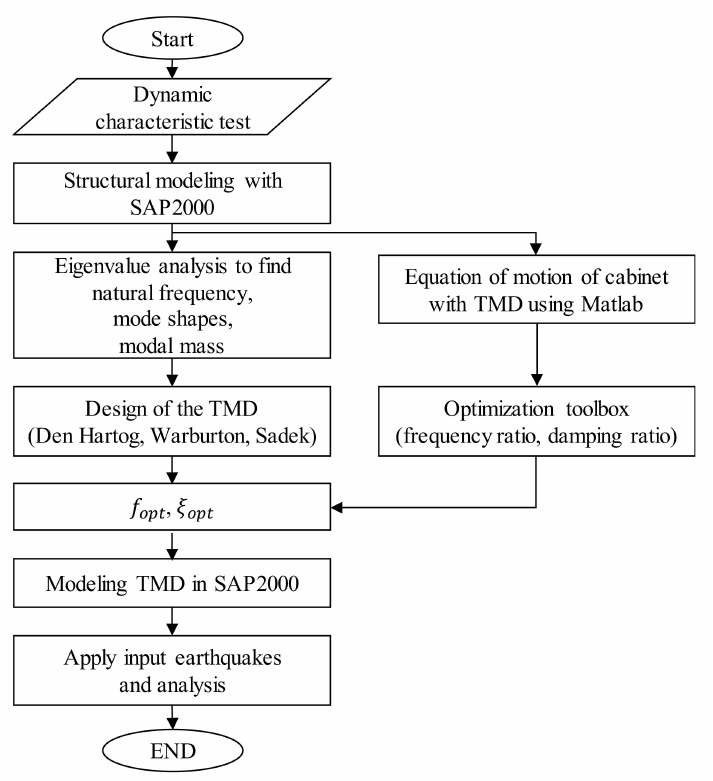
Figure 1. Tuned mass damper (TMD) design and analysis process in this study.